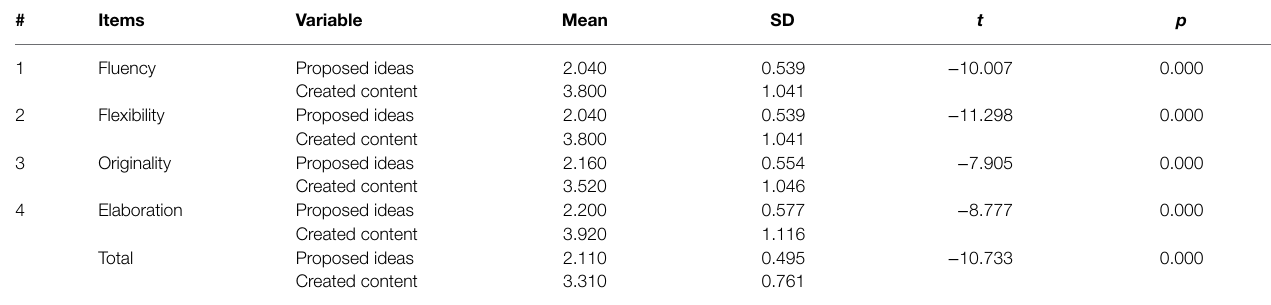
TABLE 8 | Changes in creativity: evaluation of proposed ideas and created content and their